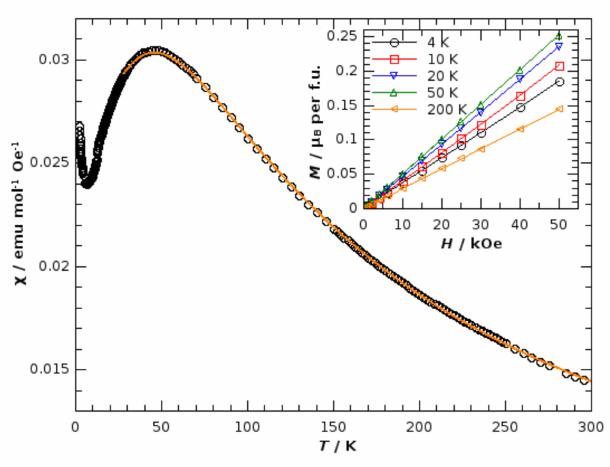
Figure 5. Temperature dependence of magnetic susceptibility, χ ( T ), measured in field of 1000 Oe. The orange solid line is the fitted curve. The inset shows the field dependence of magnetization, M ( H ), expressed in Bohr magnetons per formula unit, at different temperatures, with visual